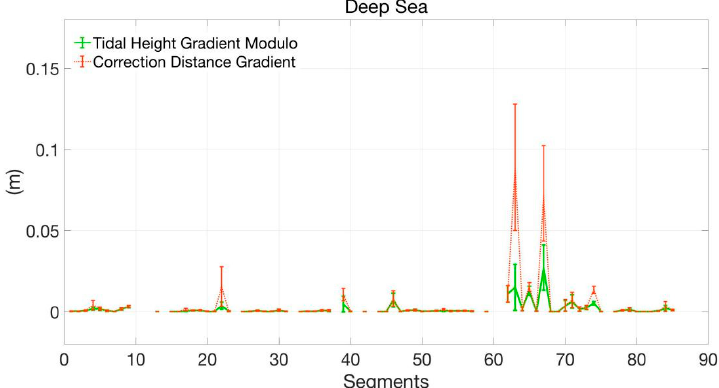
Figure 7. Tidal height gradient modulos and the corresponding tidal positioning correction gradient modulos of the deep sea segments.